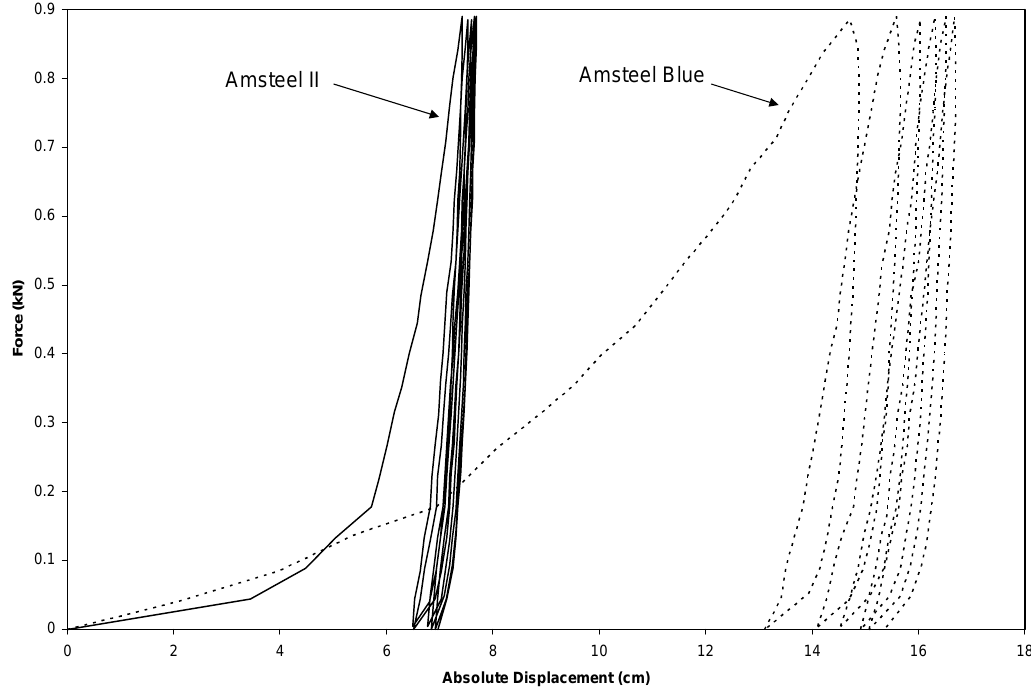
Fig. 2. Six cycles of static force versus elongation for Amsteel II and Amsteel Blue